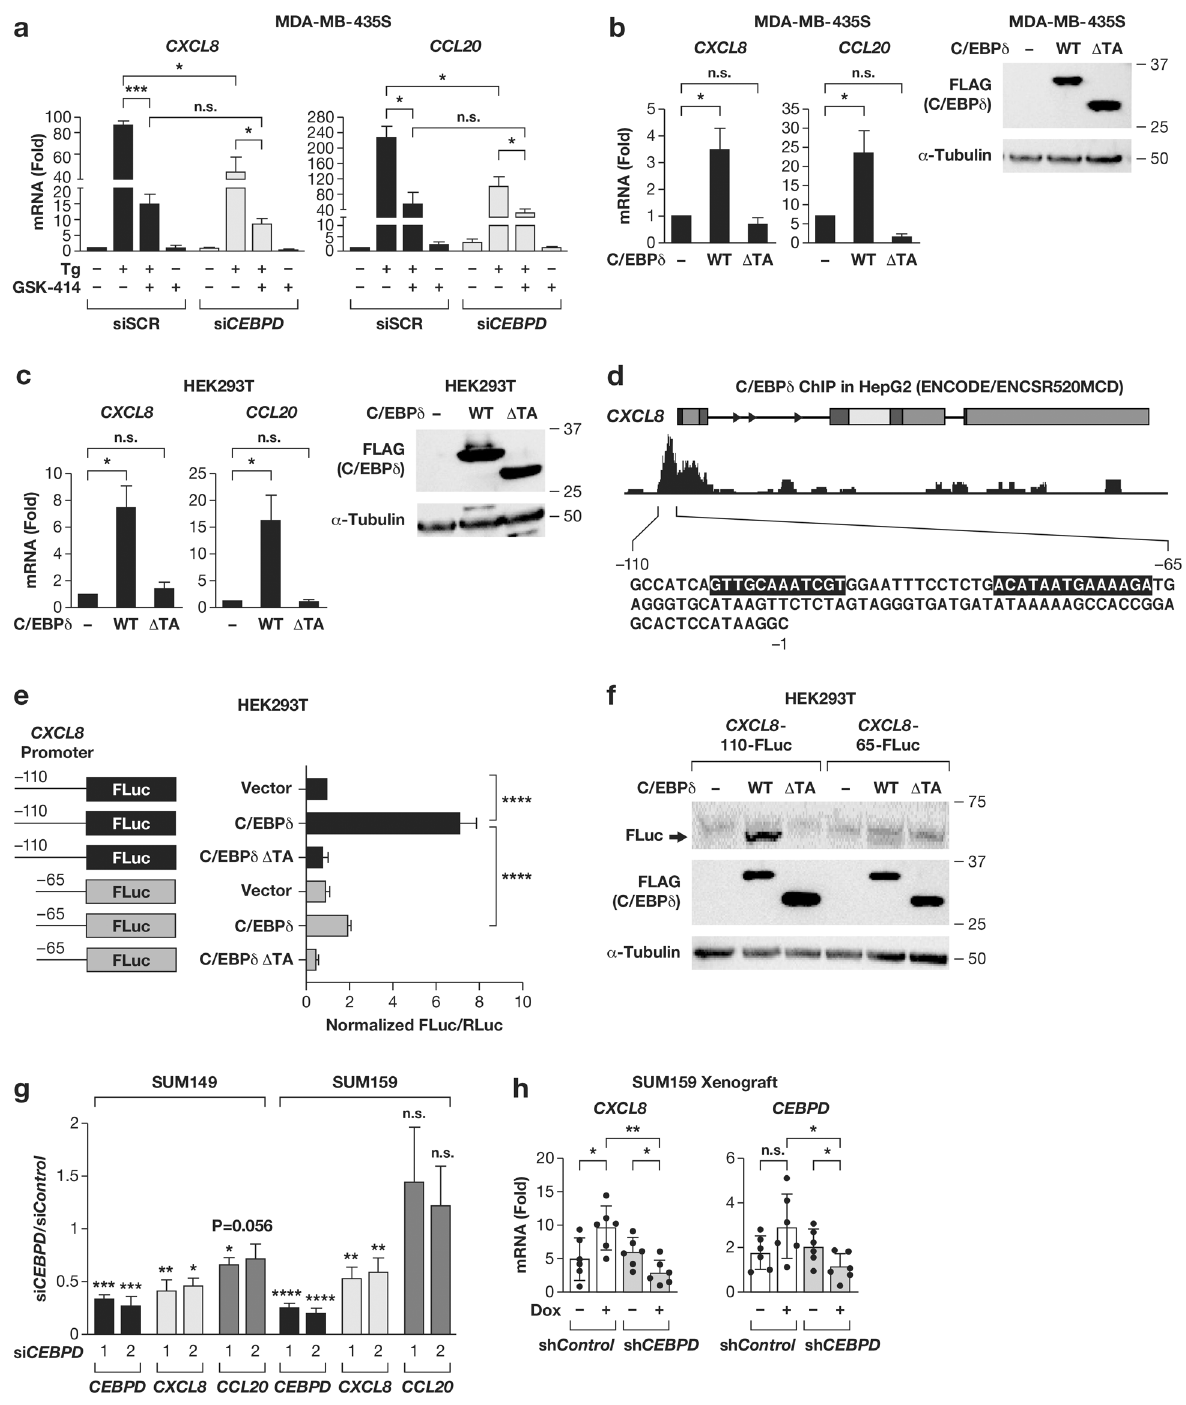
Fig. 5 C/EBP δ is suf fi cient to induce CXCL8 and CCL20 transcription. a qRT-PCR analysis of CXCL8 and CCL20 mRNA levels in MDA-MB-435S cells transfected with siSCR or siCEBPD, treated with DMSO ( − ) or Tg (100 nM) for 6 h and with or without with GSK-414 (1 µM) pre-treatment as indicated. b , c qRT-PCR analysis of CXCL8 and CCL20 mRNA levels in MDA-MB-435S ( a ) and HEK293T ( b ) cells transfected with expressing constructs of full length (WT) or transactivation domain-truncated ( Δ TA) C/EBP δ with FLAG-tag. Empty vector was used as control. Panels on the right show Western blots to demonstrate expression of ectopic C/EBP δ proteins. d Schematic of the CXCL8 gene along with the C/EBP δ ChIP-Seq track from HepG2 cells as reported by the ENCODE database, and the sequence between positions − 110 and − 1 harboring a peak and C/EBP motifs (shaded) and indicating the position ( − 65) of the deletion mutation of the reporter construct shown in e . e Luciferase reporter assay in HEK293T cells co-transfected with C/EBP δ expression constructs as in b and Fire fl y luciferase (FLuc) reporter constructs containing the proximal CXCL8 promoter region from position − 110 or − 65 to − 1. f Western blot analysis of representative extracts from e showing FLuc and C/EBP δ (anti-FLAG) protein expression. g qRT-PCR analysis of the mRNA levels of CEBPD , CXCL8 , and CCL20 in SUM149 and SUM159 cells 72 h after nucleofection with control or two independent siRNAs against CEBPD . h qRT-PCR analysis of CXCL8 and CEBPD mRNA in SUM159 xenograft tumors with Dox-inducible shRNA and with and without Dox-treatment as described [18]. Quantitative data are mean±S. E.M; a – c , g , n = 3; e , n = 4; h , n = 6; * P < 0.05, ** P < 0.01, *** P < 0.001, **** P < 0.0001; n.s., not signi fi